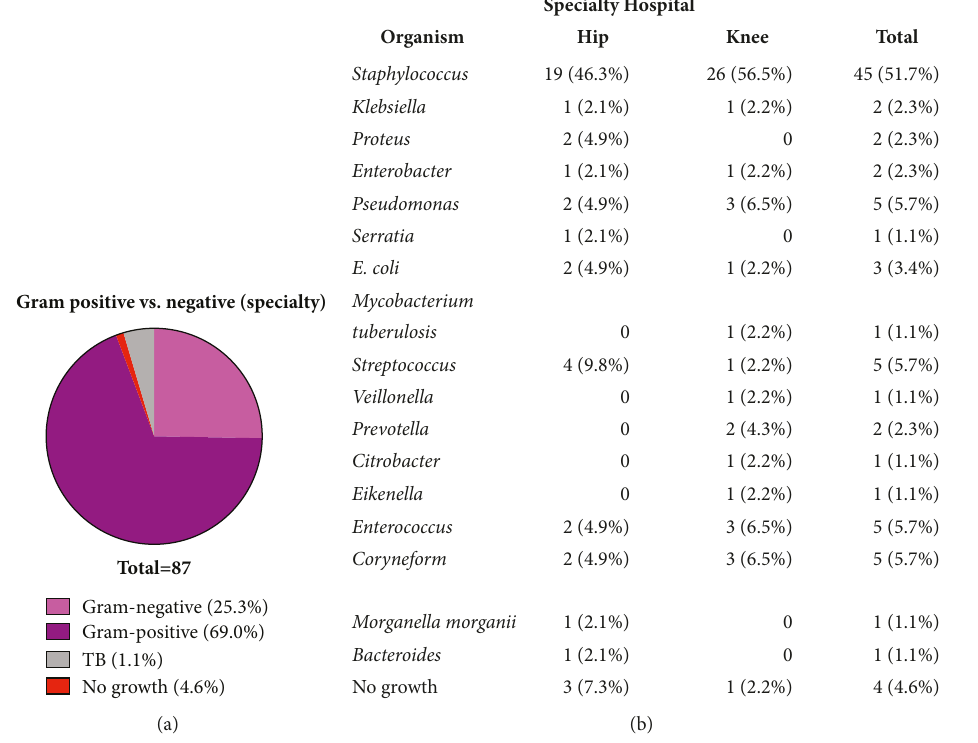
Figure 2: Increased proportion of Gram-negative PJIs at dedicated orthopaedics hospital. (a) The percentages of isolated organisms that were Gram-negative, Gram-positive, or neither or experienced no growth were examined at the dedicated orthopaedics specialty hospital. (b) The bacterial organisms in hip and knee PJIs at the dedicated orthopaedics specialty hospital were